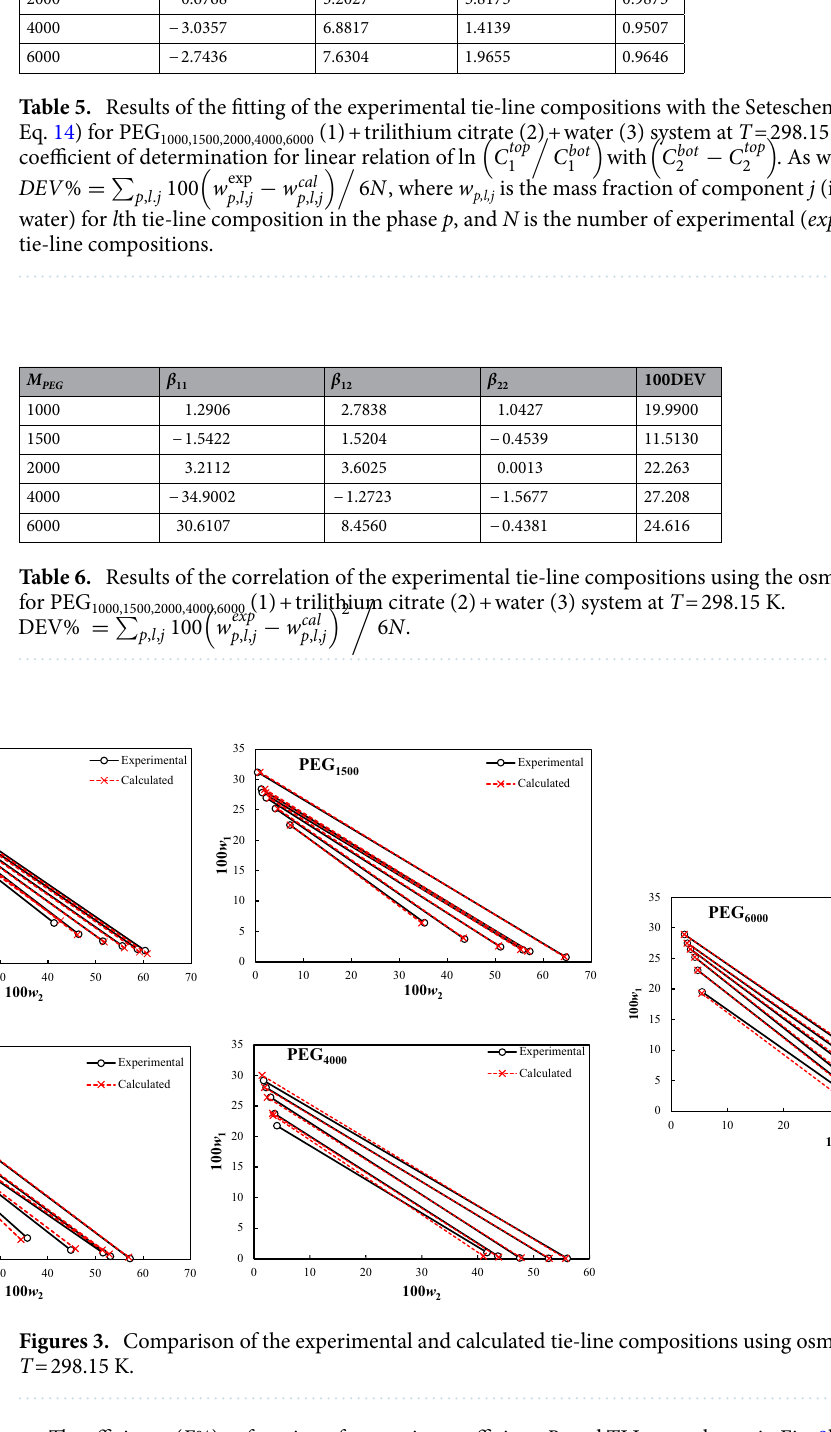
Figures 3. Comparison of the experimental and calculated tie-line compositions using osmotic virial model at T = 298.15 The efficiency ( E %) as function of separation coefficient, R , and TLL were shown in Fig. 9b, and d, respectively. In all cases, other than PEG 6000 , the E % values are lower than 50%, and the efficiency was decreased by increasing the MMP until 4000. The separation ability as function of TLL, as shown in Fig. 9c, also demonstrate that, other than PEG 6000 , the R values are lower than 1.0, which is almost increased by increasing the MMP. The inconsistence behavior of PEG 6000 is due to the more tendency of PEG 6000 to form a biphasic system. Indeed, from Fig. 9c it can be inferred that, the mass of the polymer-affluent phase is higher than the salt-affluent phase. In other words, PEG 6000 can catch more water molecules from the stock solution in competition with the